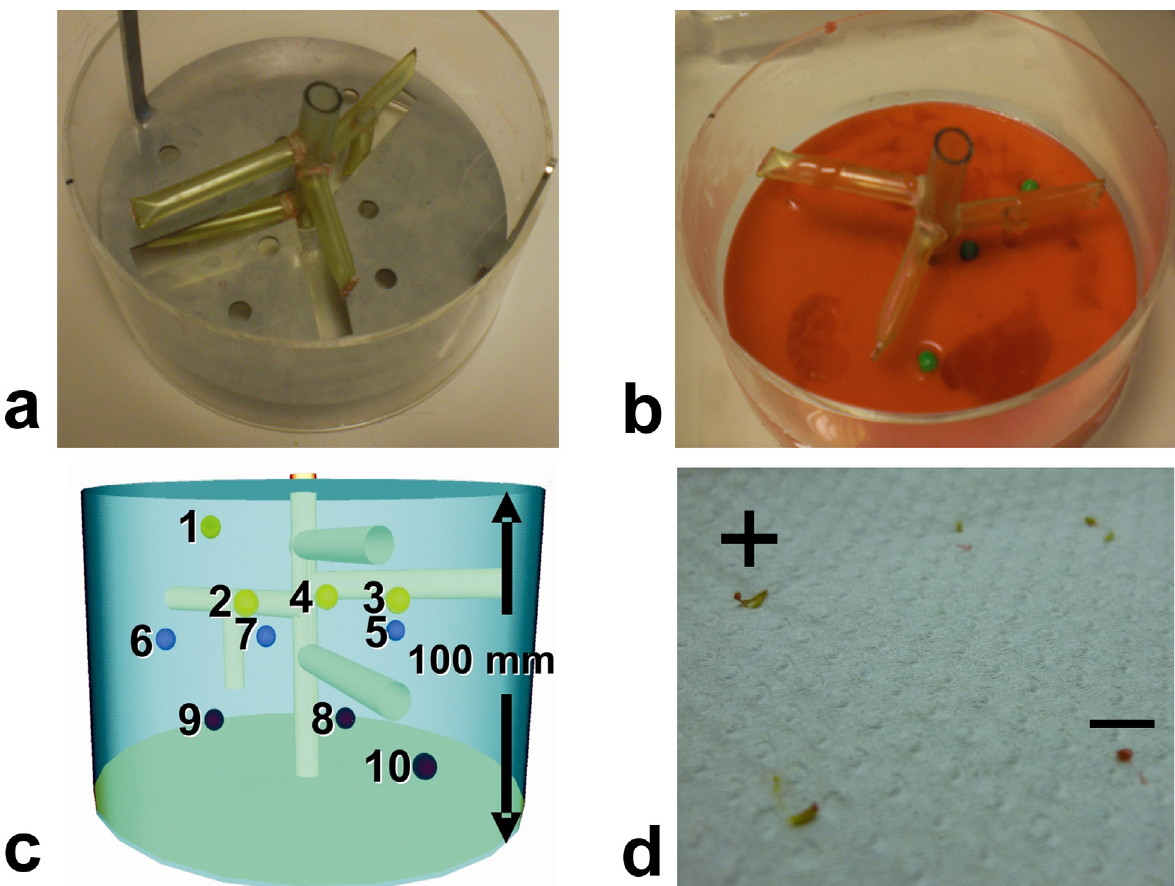
Fig 2. Standardized biopsy phantom. (a) Acrylic glass cylinder (10 cm high and 20 cm in diameter) with model vasculature and target positioning template. A three-dimensional structure of silicone tubes served as model vasculature that needed to be avoided. Custom-drilled holes inside a stainless steel disc ensured that experimental targets were placed in the same 3D positions for all trials. (b) The tissue phantom was made out of ordinary red cake glaze in double concentration (160 g powder per 400 ml of water). Ten ordinary green peas were embedded as biopsy targets. The surface of the hardened glaze was later impregnated with a virucidal hand disinfectant (Sterilium Viruguard) and the phantom was stored in a refrigerator. (c) Target difficulty varied with insertion depth (four distinct levels between 17 – 76 mm from the phantom surface) and placement with respect to the vasculature. Three targets (# 4, 7 and 9) were located under a vessel or another target and could only be accessed by an oblique path. (d) Photograph of tissue samples taken with the fully automatic biopsy gun. Biopsy was counted as success when sample contained green material from the pea (+ sign). Samples of base material (cake glaze) appeared red ( –